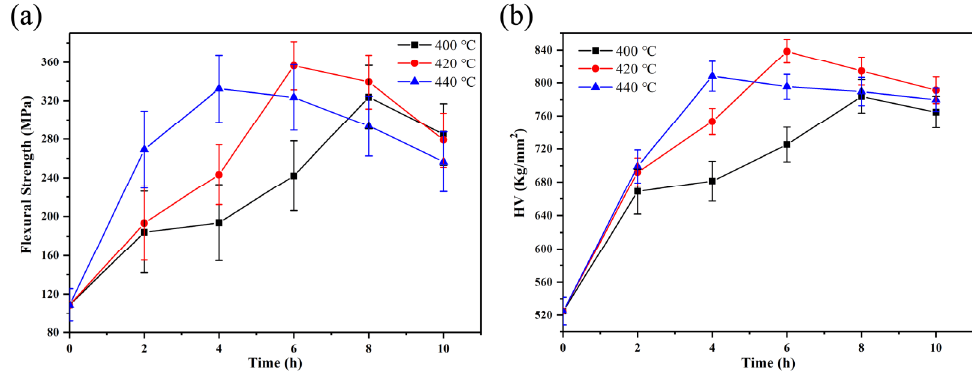
Figure 4. ( a ) Flexural strength and ( b ) Vickers hardness of T2 LAS GCs after ion-exchange at different temperatures for 2 h.